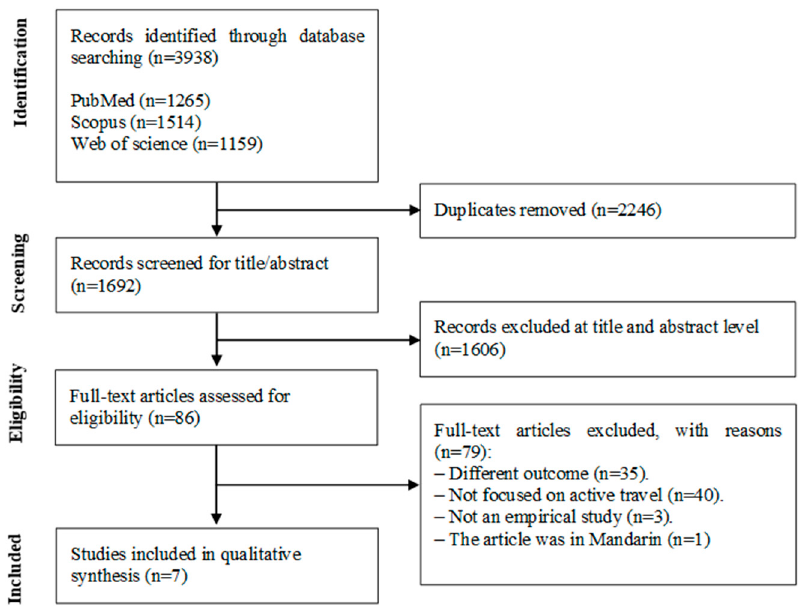
Figure 1. Flow diagram of study selection.